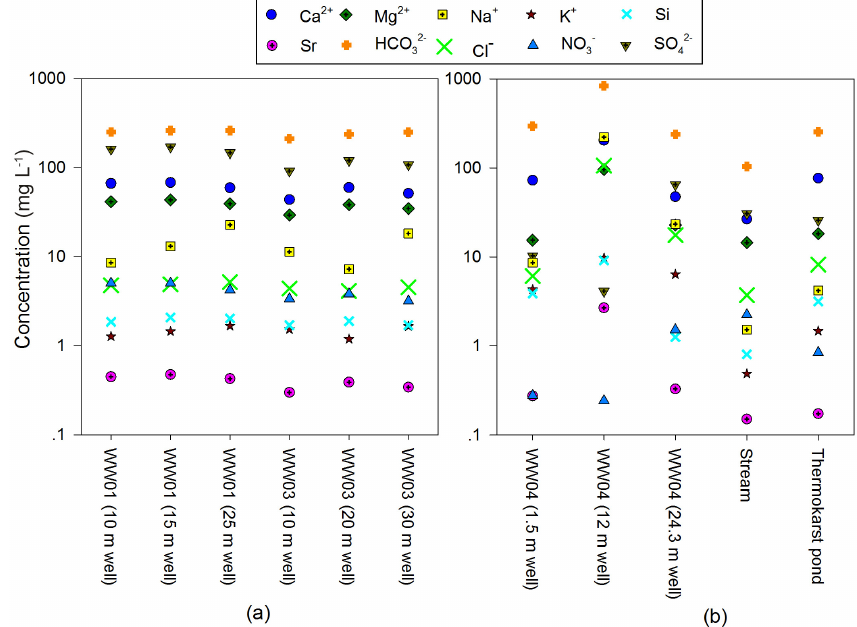
Figure 7. (a) Groundwater chemistry at different depths of the two clusters within the seasonal frost zone and (b) chemistry of groundwater, stream water and thermokarst pond water within the permafrost zone. WW01, WW03 and WW04 are symbols for clusters. The number in brackets means the specific screen depth of wells. Note the log scale on the y